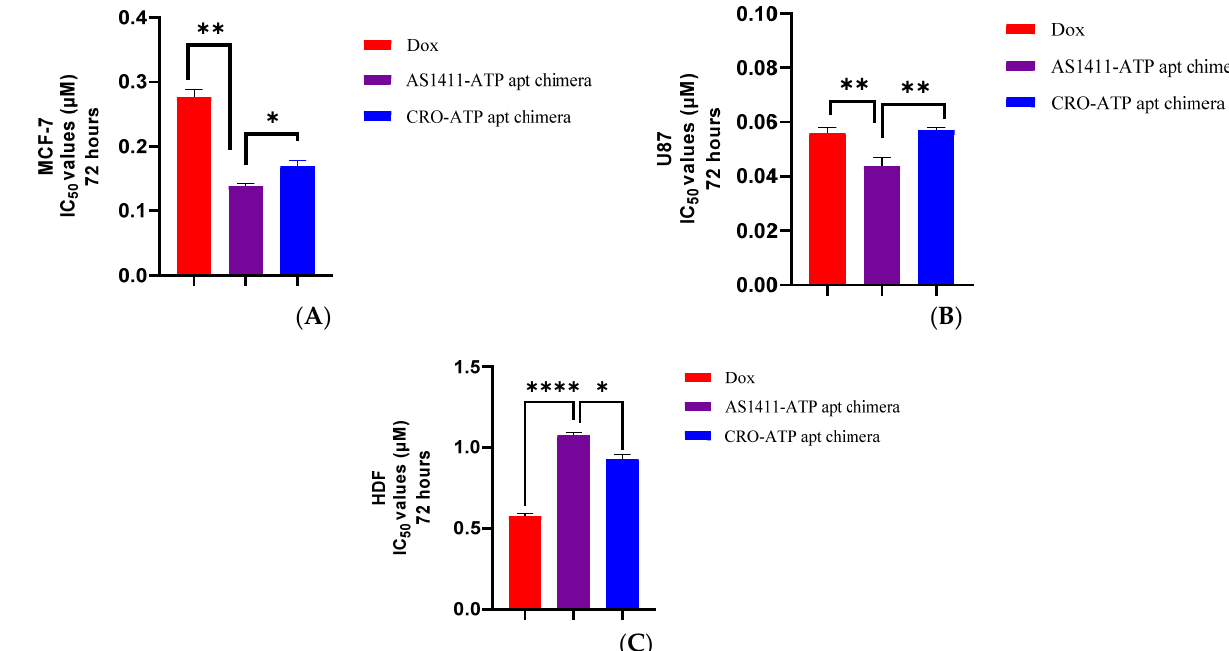
Figure 6. IC 50 values after 72 h of incubation of the chimeras with cell lines. ( A ) MCF-7 cell line. ( B ) U87 cell line. ( C ) HDF cell line. Error bars indicate SD ( n = 3). * p < 0.05, ** p < 0.01, **** p < 0.0001 (one-way ANOVA).